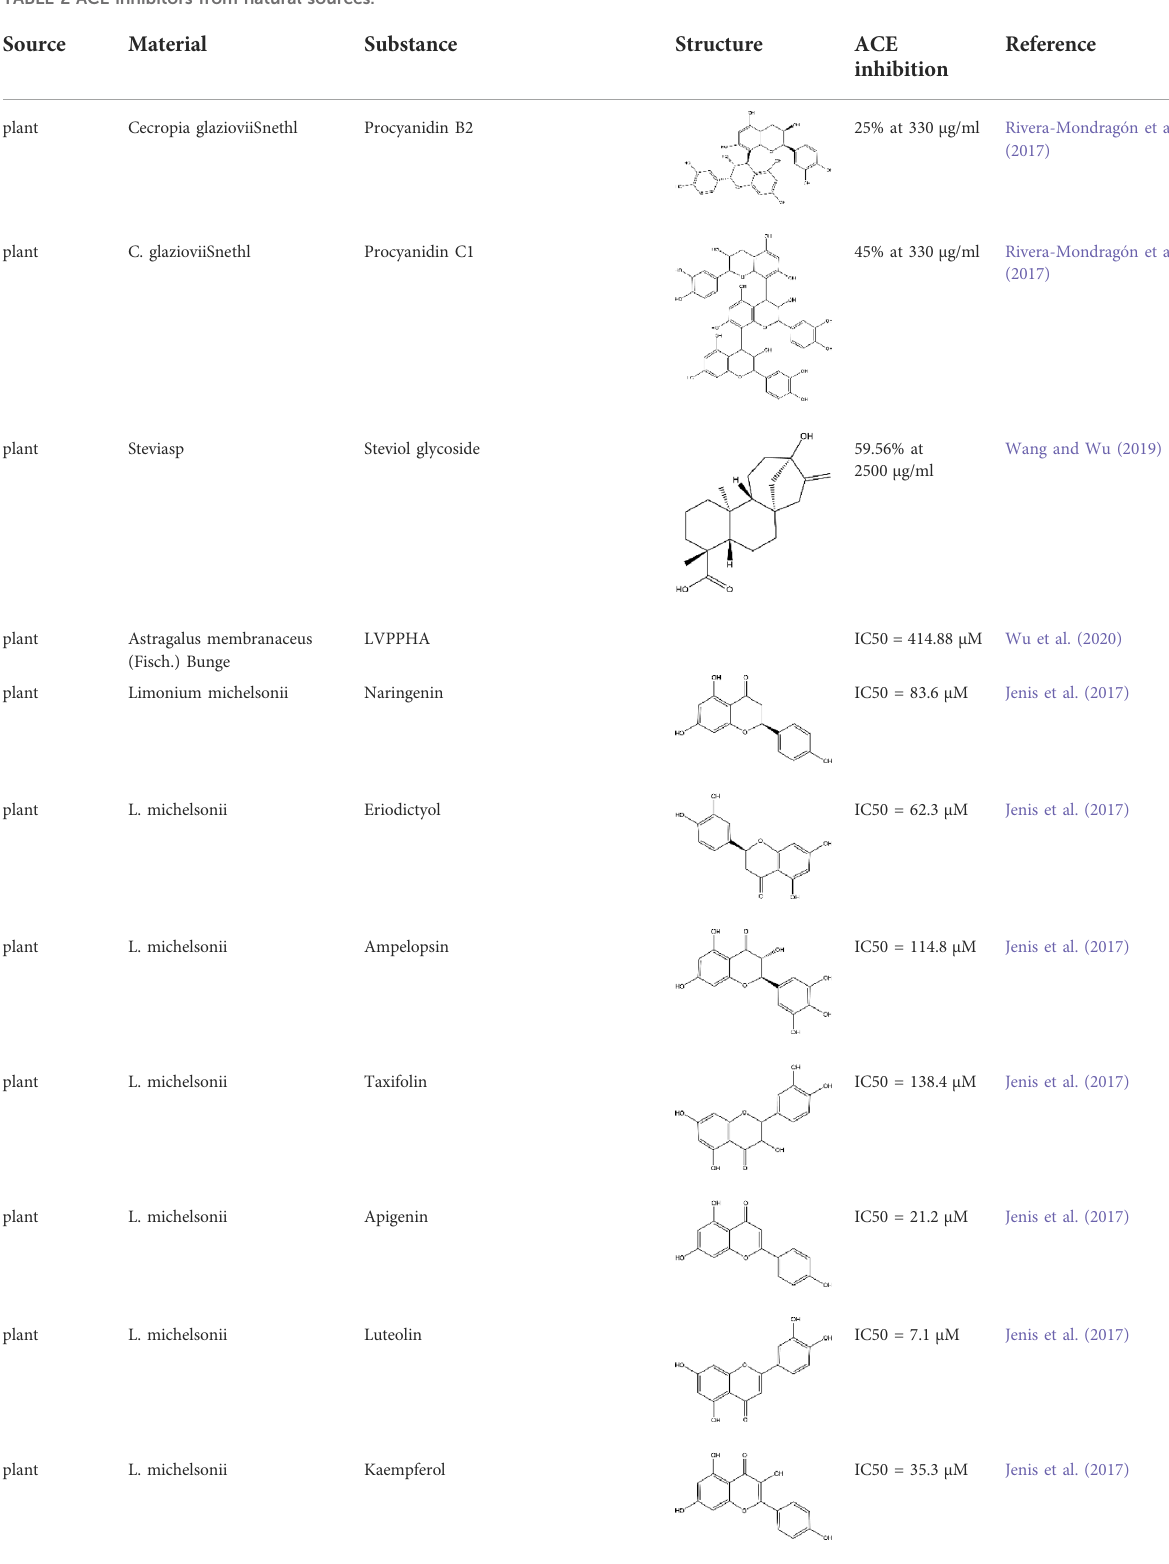
TABLE 2 ACE inhibitors from natural